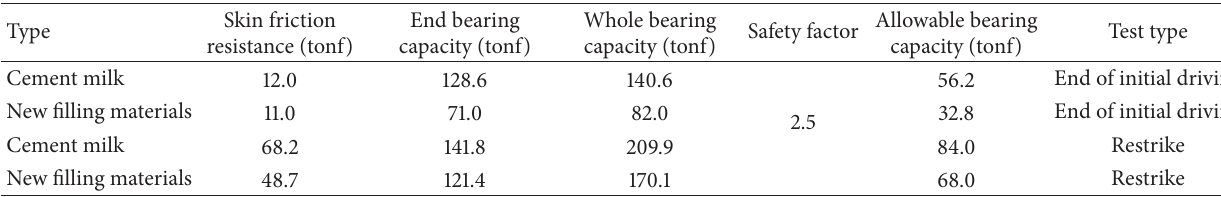
Table 6: CAPWAP analysis results.